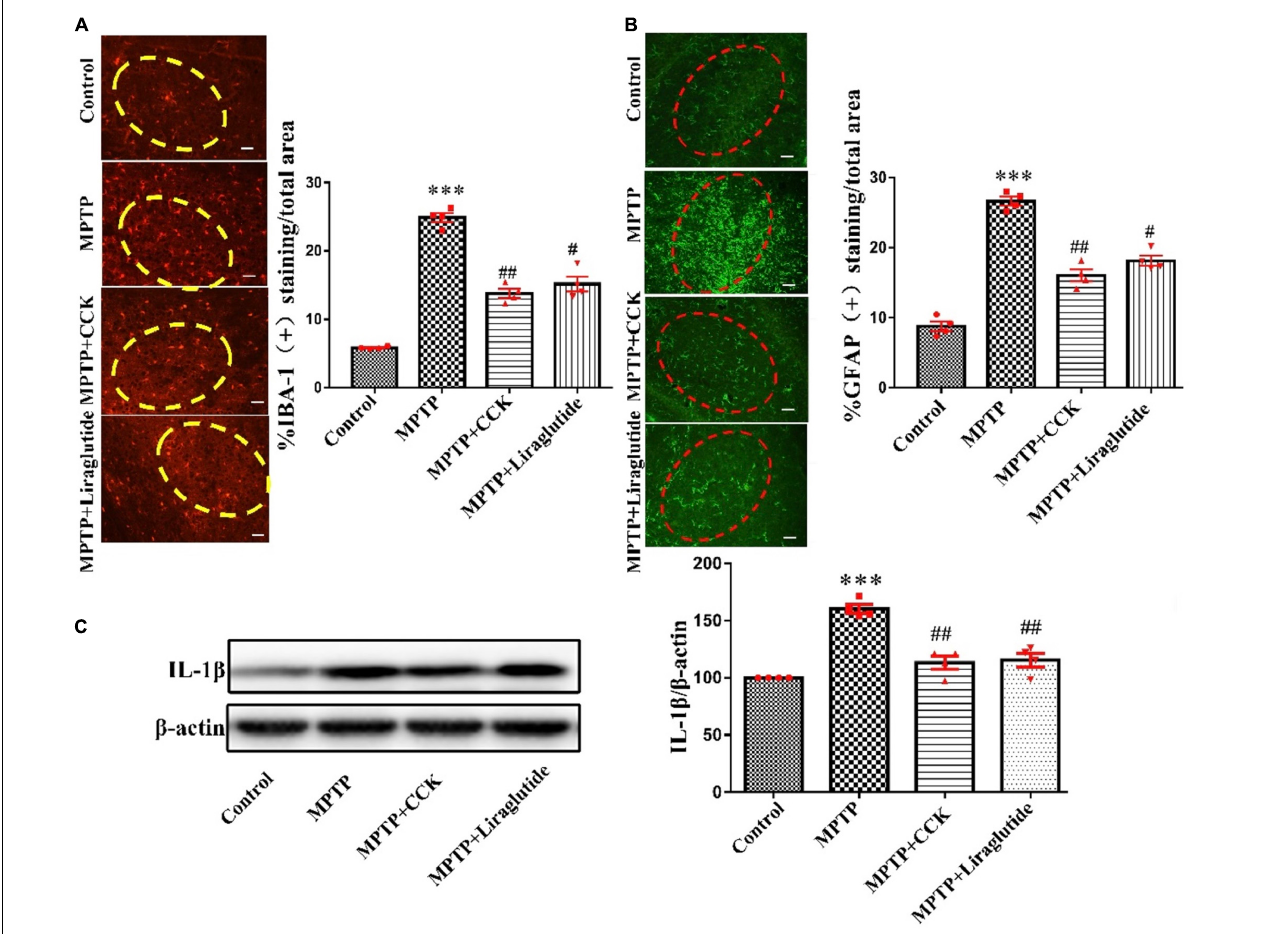
FIGURE 4 | Liraglutide and the CCK analogue decreased microglia and astrocytes activation and the release of inflammatory cytokines induced by MPTP (The region of the ellipse is substantia nigra pc). (A) The expression of IBA-1 in the SNpc of mice in each group (scale bar: 50 µ m). (B) The expression of GFAP in the SNpc of mice in each group (scale bar: 50 µ m). (C) Expression of inflammatory cytokines IL-1 β in the SNpc of mice in each group. ∗∗∗ P < 0.001, compared with the control group, # P < 0.05, ## P < 0.01, compared with the MPTP group, n = 4 per group.